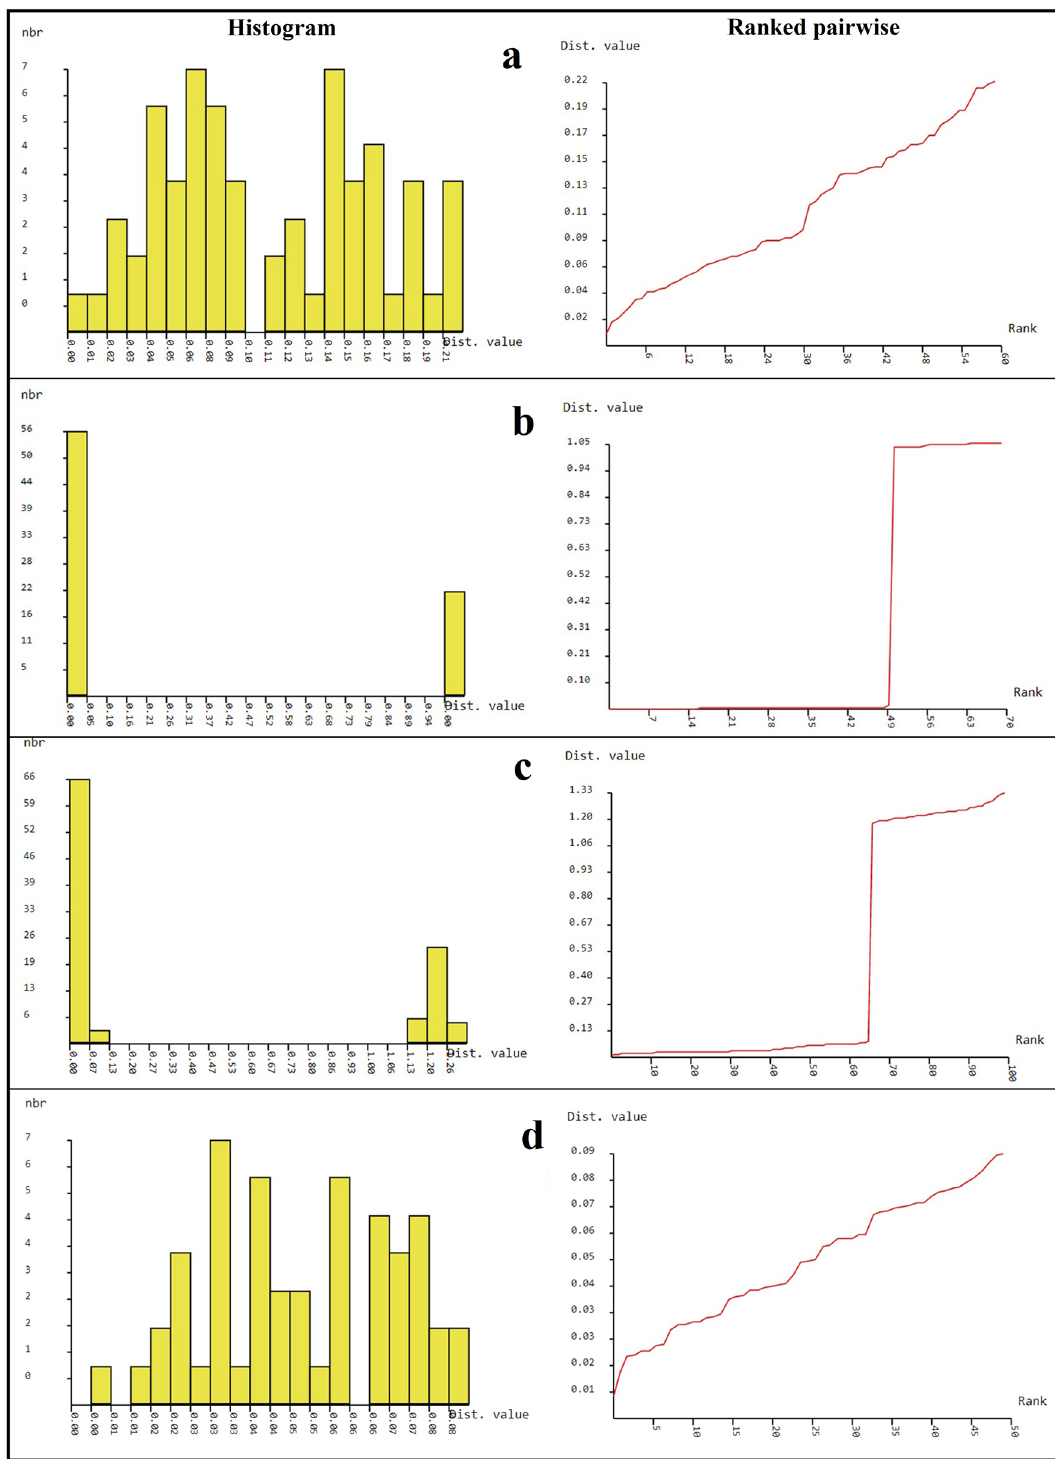
Figure 6. Histogram and ranked pairwise (K2P) distances among barcode sequences by automated barcode gap discovery (ABGD) approach. The analysis of barcode gap using ITS ( a ), matK ( b ), rbcL ( c ) and concatenated sequences ( d ) of P. trimera and